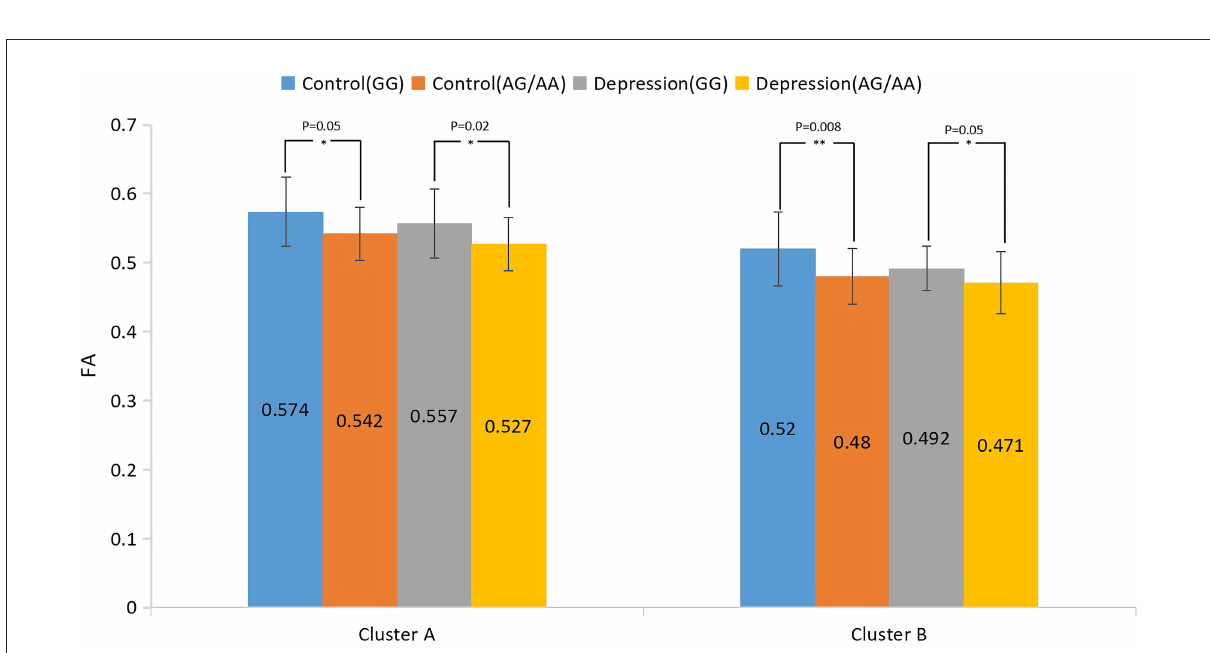
FIGURE4 Post-hoc analysis of the main effect of genotype on FA among the four groups. * P < 0.05, ** P < 0.01.